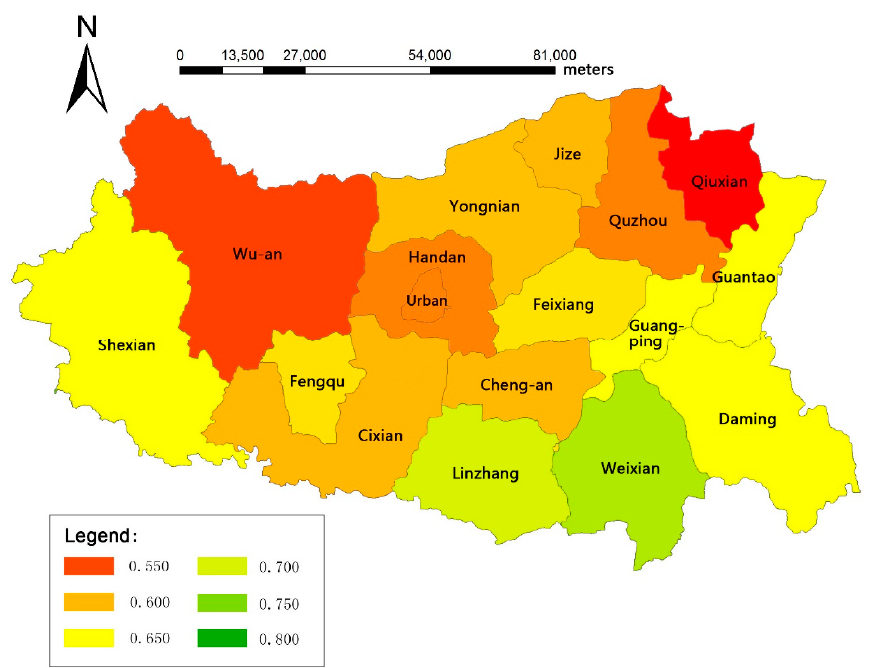
Figure 9. Spatial distribution of SWA in the hydrological dry year (2006).